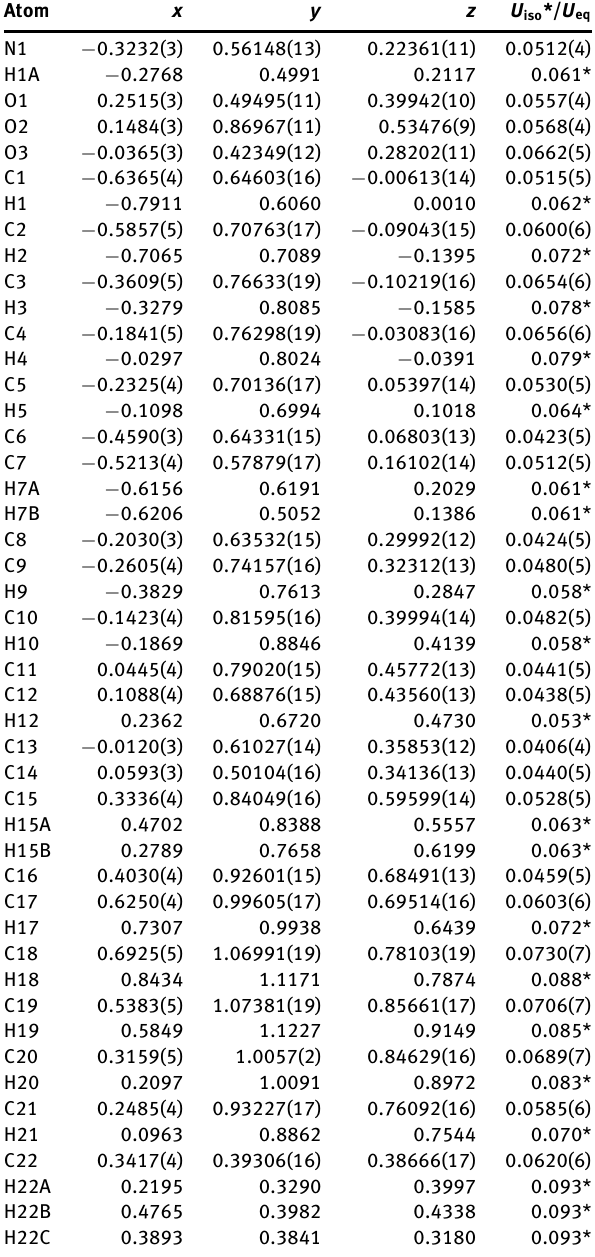
Table 2: Fractional atomic coordinates and isotropic or equivalent isotropic displacement parameters (Å 2